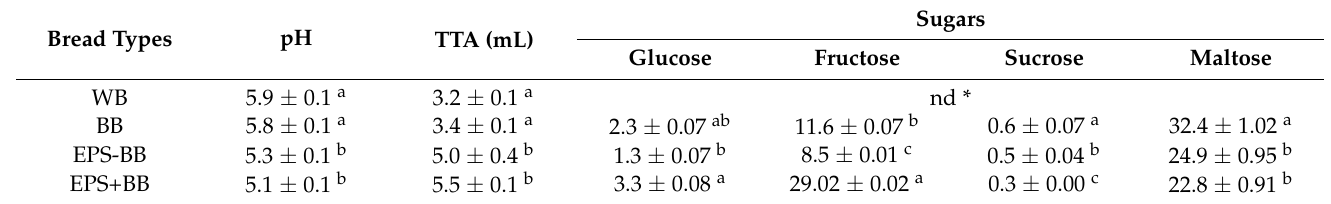
Table 5. Acidity (pH and TTA) and sugar analysis of BSG breads (WB: wheat bread, BB: native BSG NaOH required during titration. Amount of sugars are expressed g/kg of dried breads.